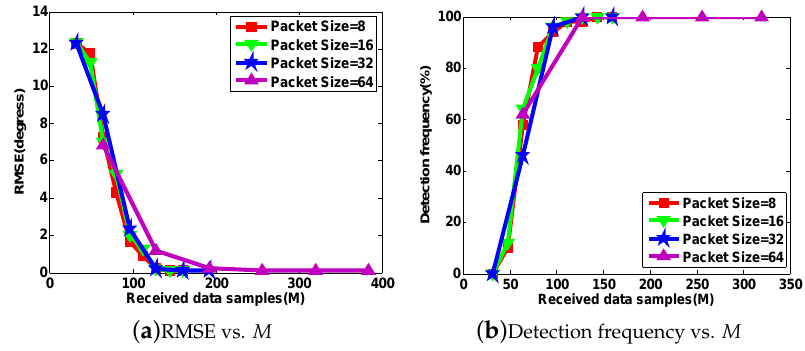
Figure 14. The DOA RMSE and detection frequency for DCS-DOA versus M under different packet